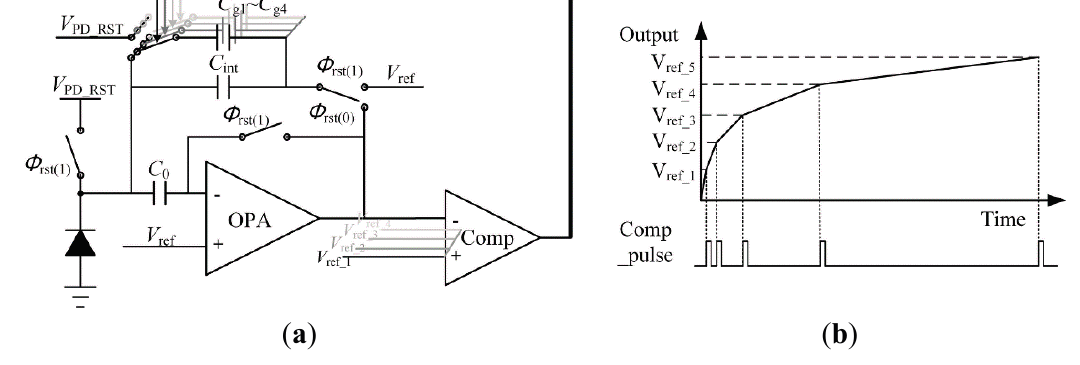
Figure 2. ( a ) The structure of CTIA; ( b ) The output curve of